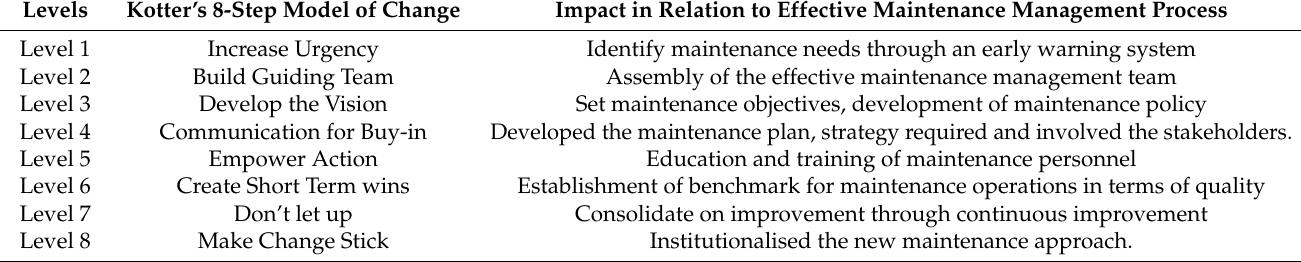
Table 2. Change concerning culture as a variable for effective MM of buildings using Kotter’s 8-step